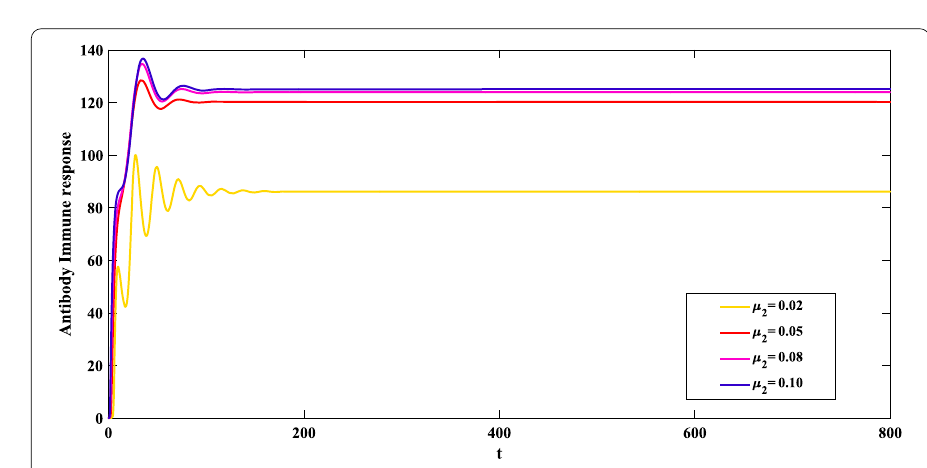
Figure 3 The phase diagram shows that the neutralizing antibody converges to a certain extent after the regulation of free viruses and infected cells